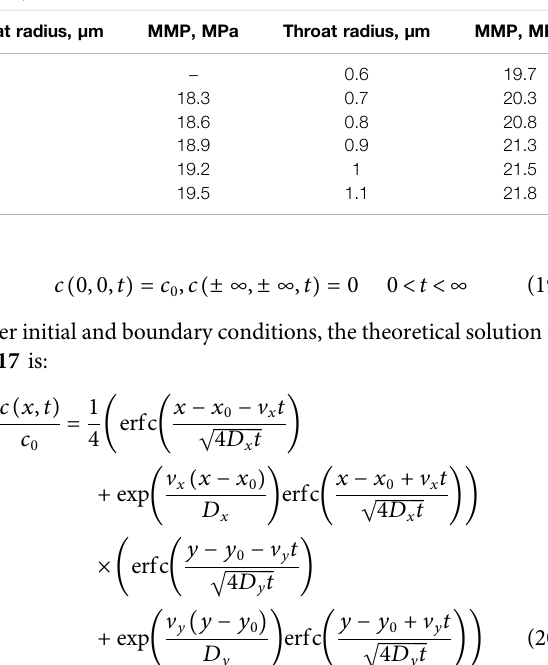
TABLE 3 | The throat radius of the core sample corresponds to the minimum miscible pressure.